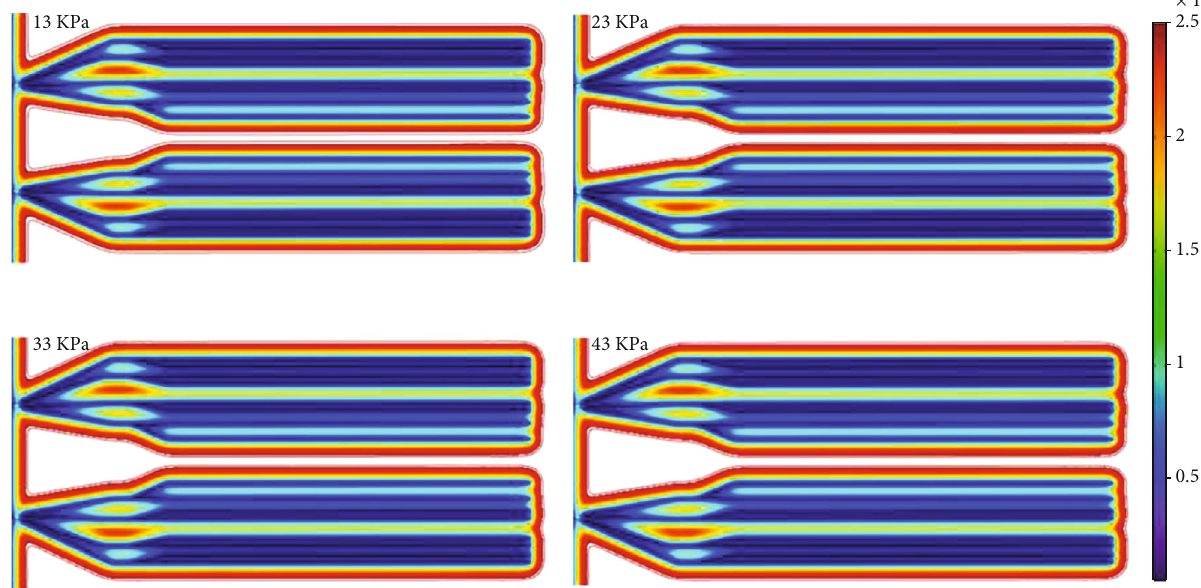
Figure 6: Gas pressure changes under di ff erent negative pressures (after 400